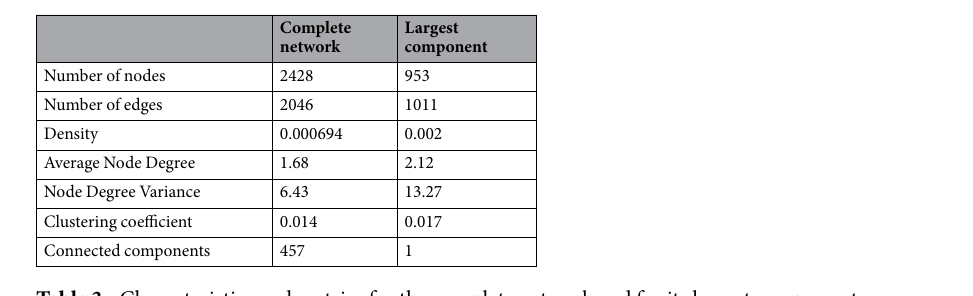
Table 3. Characteristics and metrics for the complete network and for its largest component.